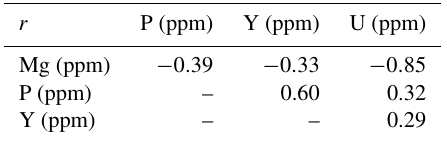
Table 2. Pearson correlation coefficients r between elements calcu- lated using 10-point running averages. All values are significant at P < 0 .